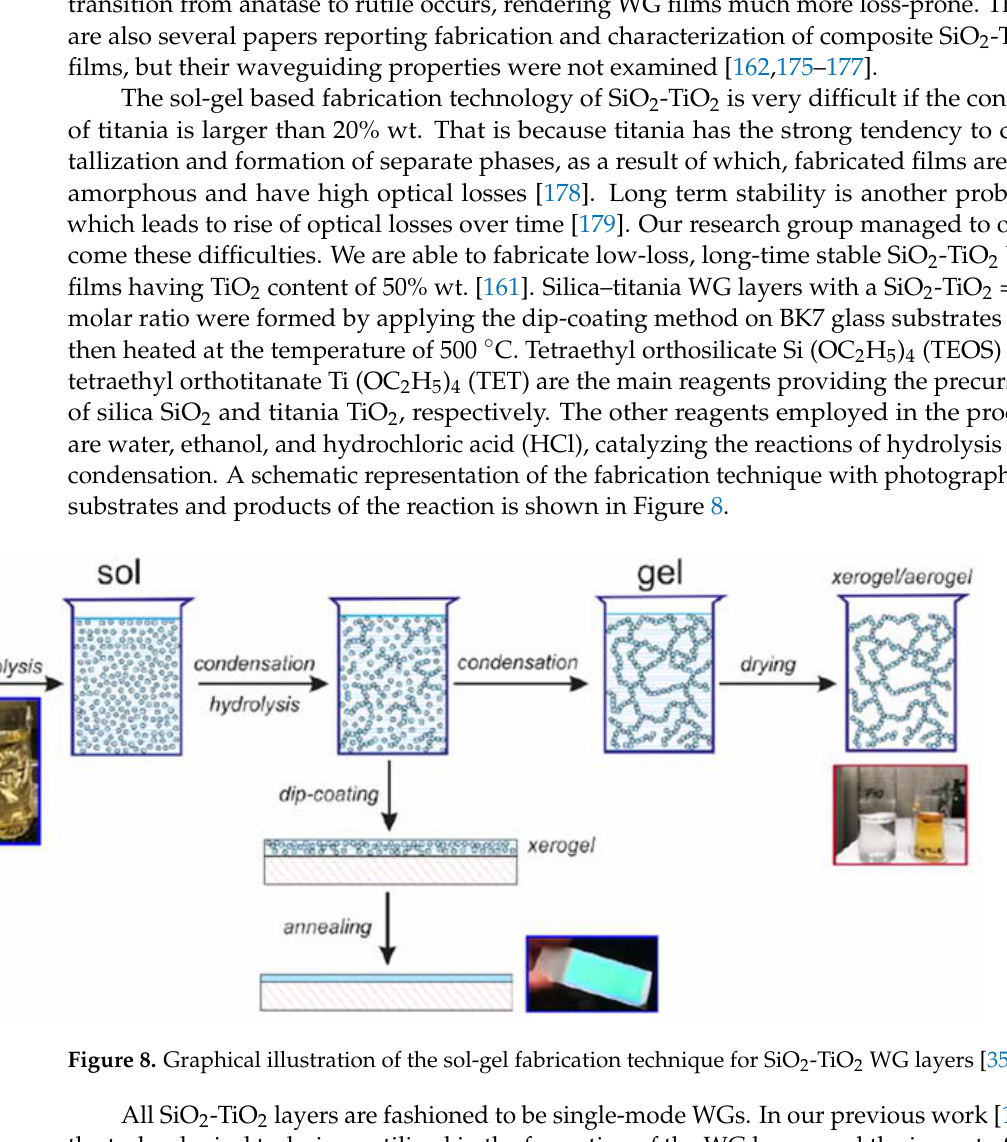
2 -TiO 2 WG layers